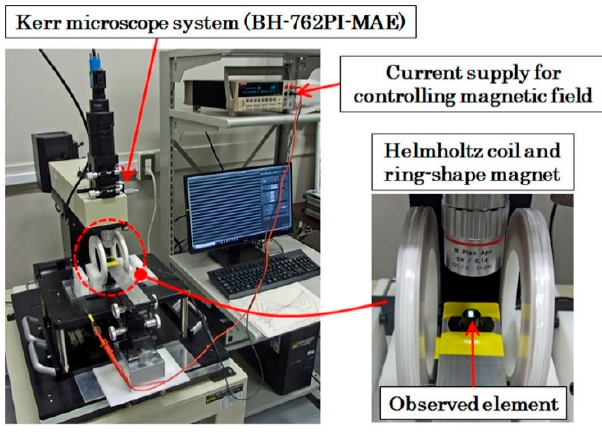
Figure 5. Photo of the measurement apparatus.